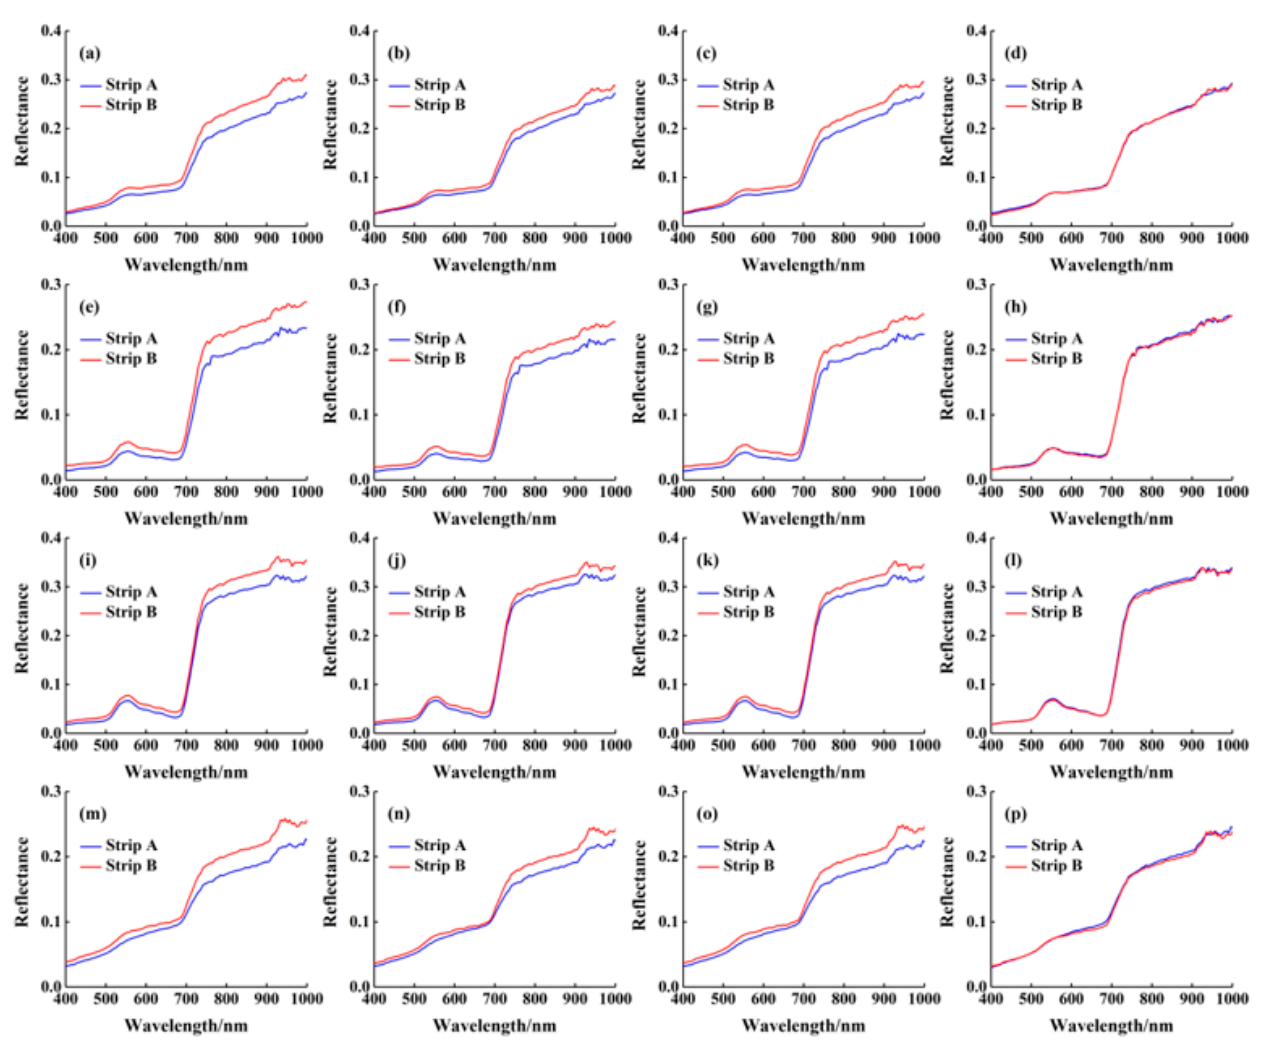
Figure 9. An example of the reflectance curves of the homonymous points for herb ( a – d ), shrub ( e – h ), tree ( i – l ), and bare soil ( m – p ) in the adjacent images. ( a ) Uncorrected, ( b ) SCS+C, ( c ) Minnaert+SCS, ( d ) RA-TOC-CA; ( e ) Uncorrected, ( f ) SCS+C, ( g ) Minnaert+SCS, ( h ) RA-TOC-CA; ( i ) Uncorrected, ( j ) SCS+C, ( k ) Minnaert+SCS, ( l ) RA-TOC-CA; ( m ) Uncorrected, ( n ) SCS+C, ( o ) Minnaert+SCS, ( p ) RA-TOC-CA.